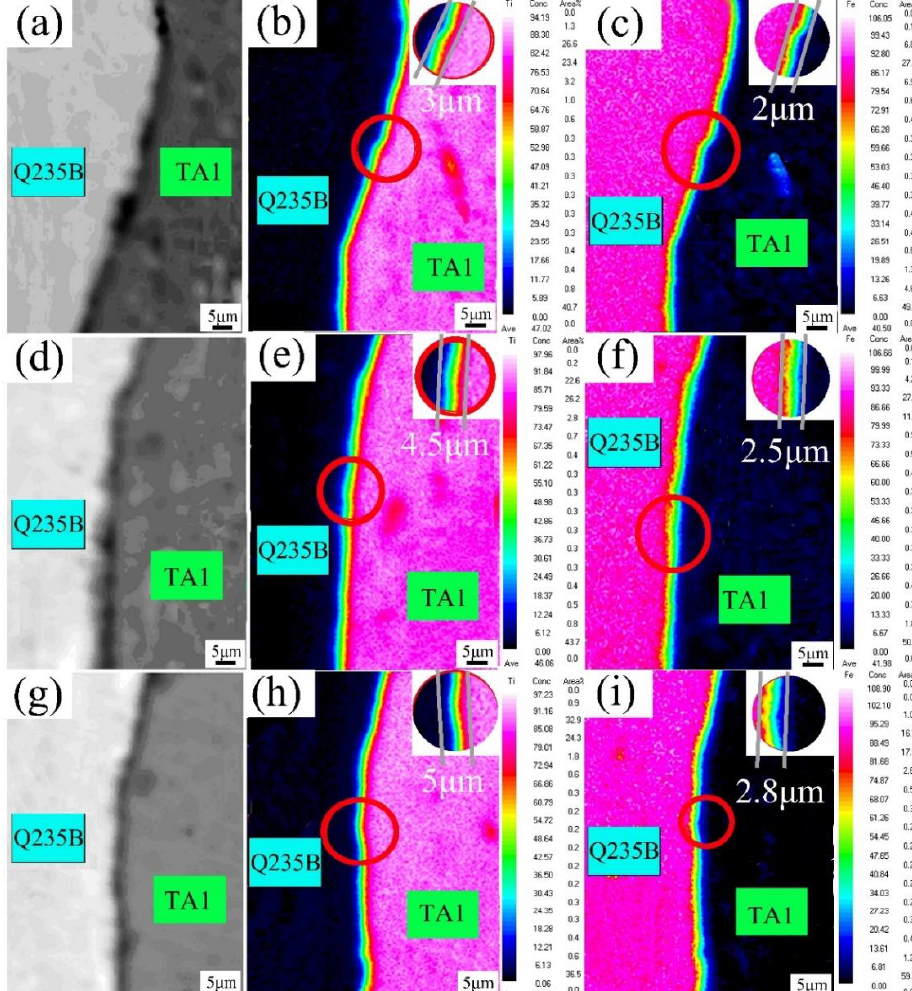
Figure 9. Electron probe micro-analysis (EPMA) element distribution in the interface of TA1/Q235B sheets hot rolled at ( a–c ) 1003 K, ( d–f ) 1053 K and ( g–i ) 1103 K, ( a , d , g ) are microstructures, ( b , e , h ) are Ti elements and ( c , f , i ) are Fe elements.